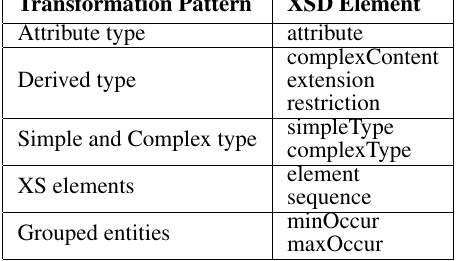
Table 3. Preparatory patterns implemented by OGGD for transforming XSD elements into to